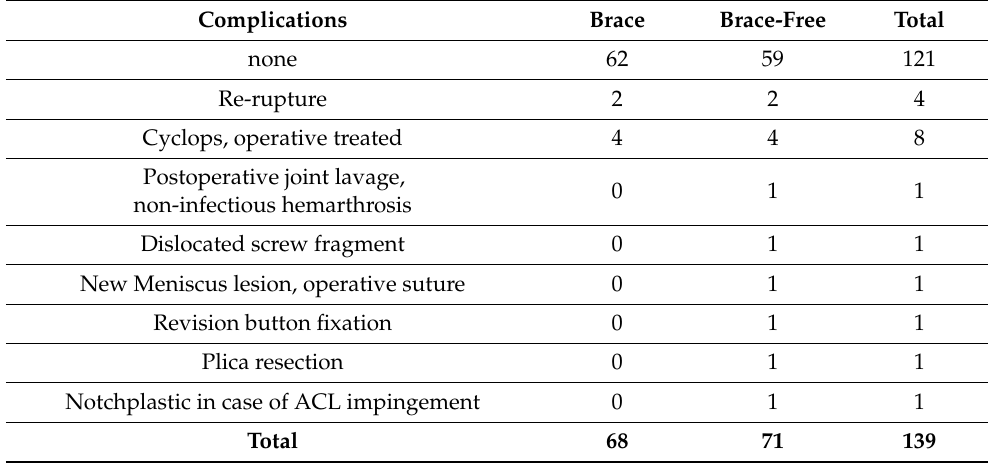
Table 4. Complications post-randomisation.